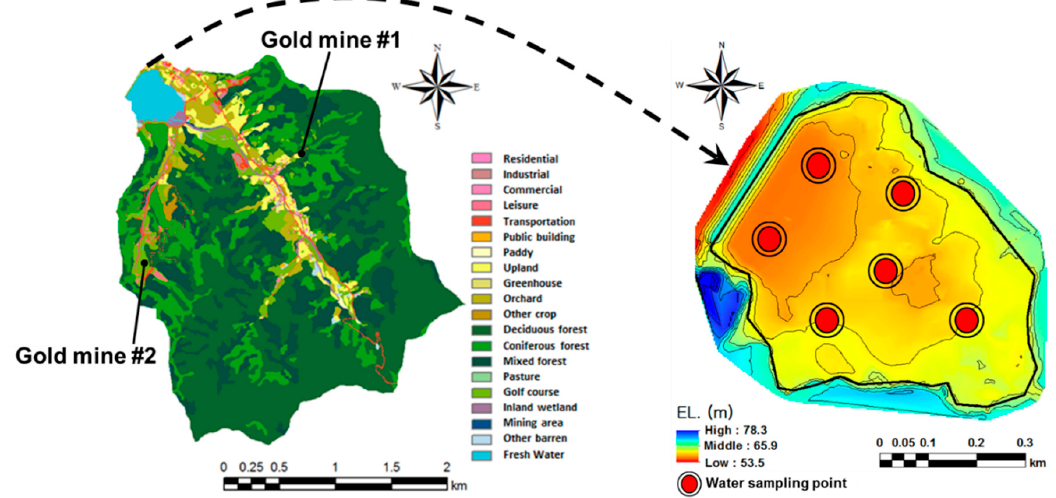
Figure 1. Study areas and sampling points for arsenic ‐ laden sediment.